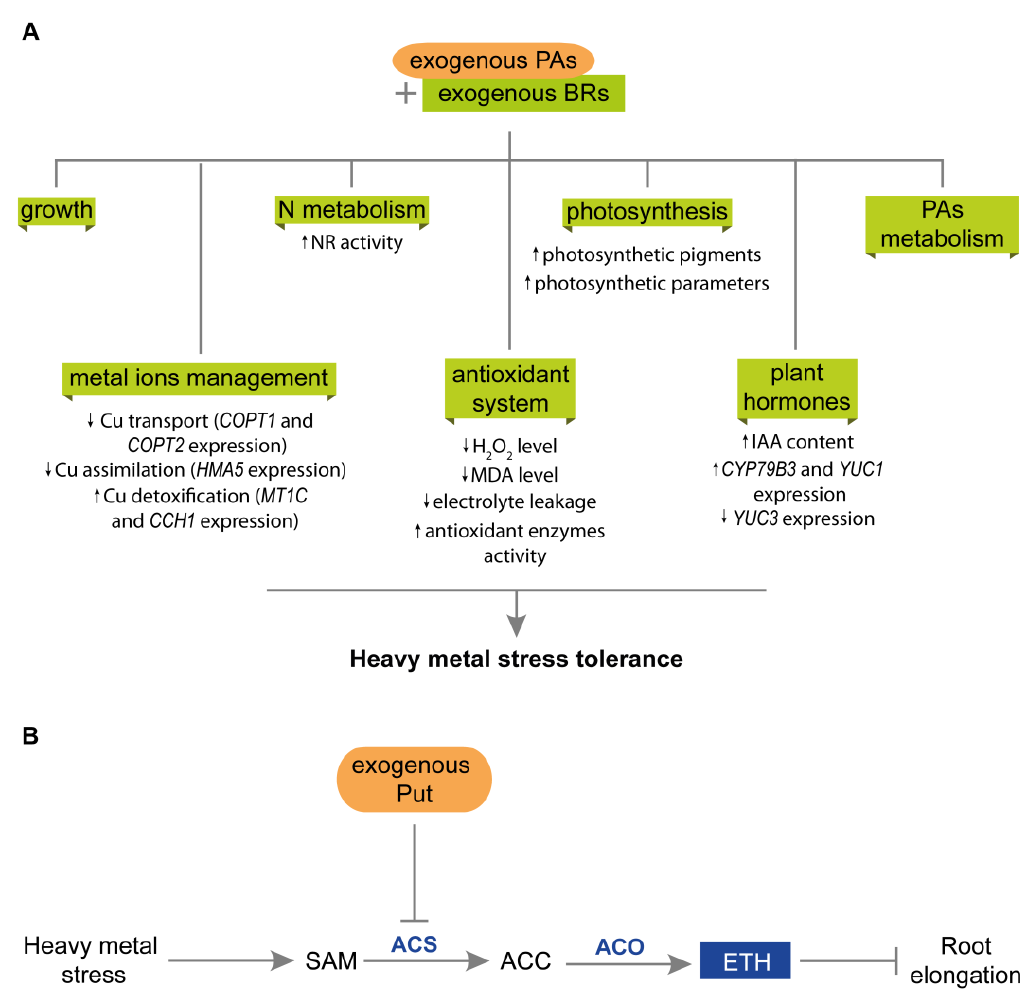
Figure 5. Interactions between PAs and plant hormones during plant responses to heavy metal stress. ( A ) Synergistic action of exogenous PAs and BRs in plants exposed to heavy-metal stress.